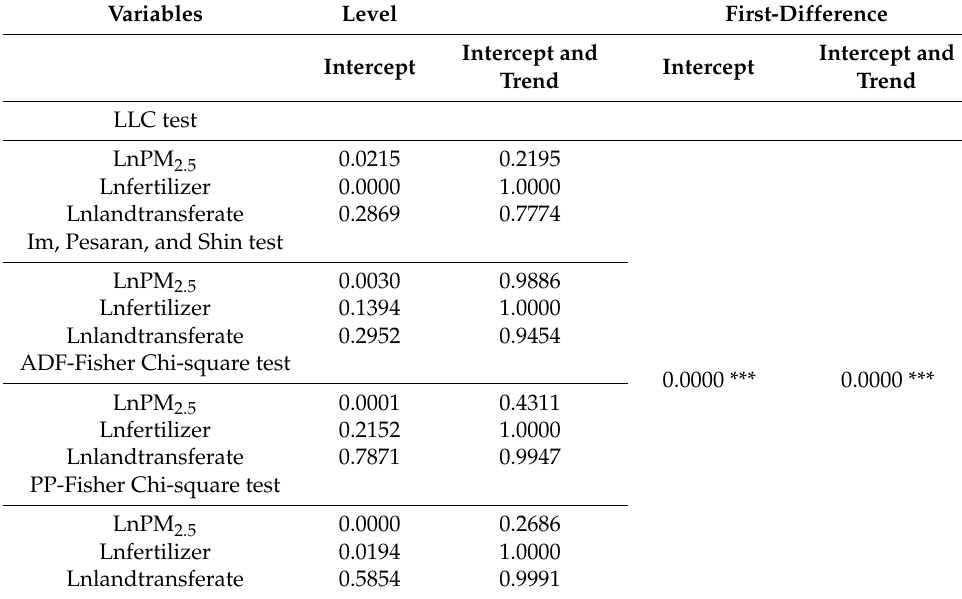
Table 3. Panel unit root tests results.